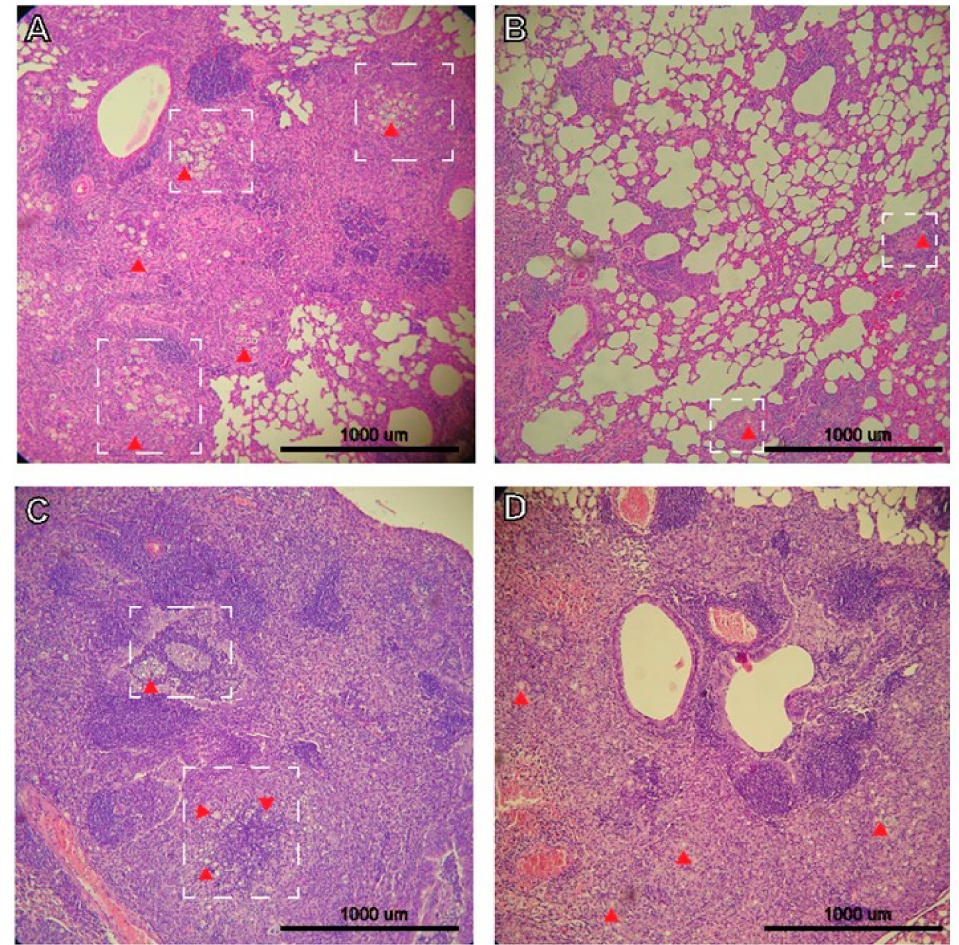
Figure 2. Impact of neutrophils on the lung inflammatory response. Infected mice were given an IgG2b isotype control on days 14, 21, and 28 post infection, and either PBS ( A ) or P10+DODAB ( B ) on days 15, 22, and 29 post infection with P10+DODAB. Another set of mice were infected and given neutrophil-depleting antibody Gr1 on days 14, 21, and 28 post infection, and either PBS ( C ) or P10+DODAB ( D ) on days 15, 22, and 29. Mice were euthanized 36 days post infection and the inflammatory response in the lungs was evaluated by histology using hematoxylin/eosin stain. 100 × magnification. Red arrow = P. brasiliensis yeasts; dashed white square = area with high concentration of yeast/granuloma